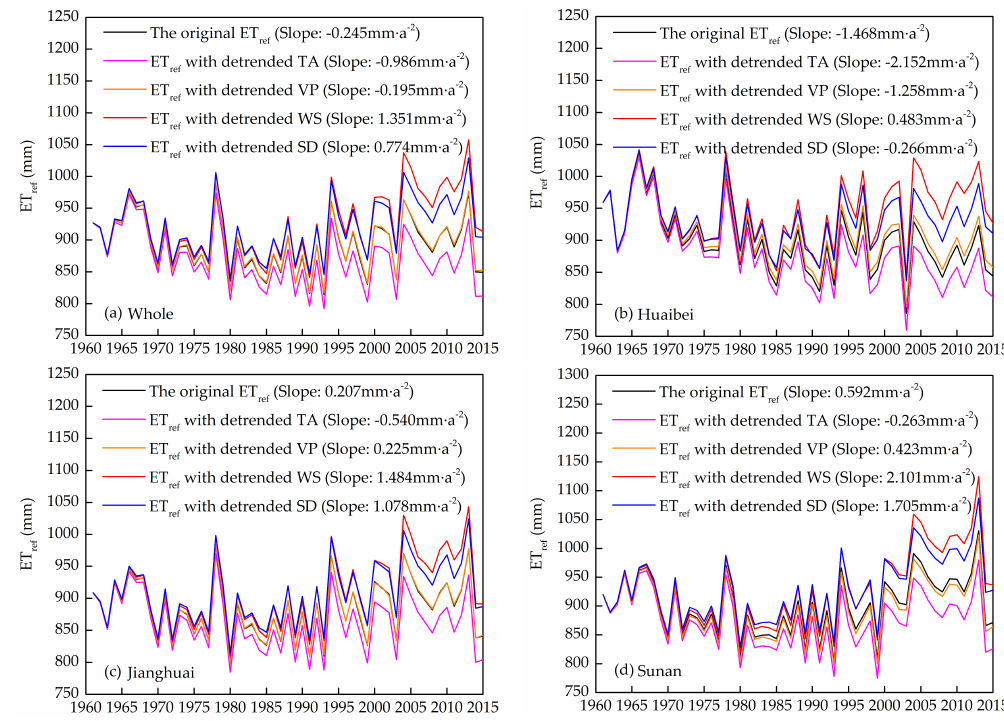
Figure 5. Contributions of climatic factors to the trends in ET ref in ( a ) Whole, ( b ) Huaibei, ( c ) Jianghuai, and ( d ) Sunan regions of the Jiangsu province during 1961 − 2015.